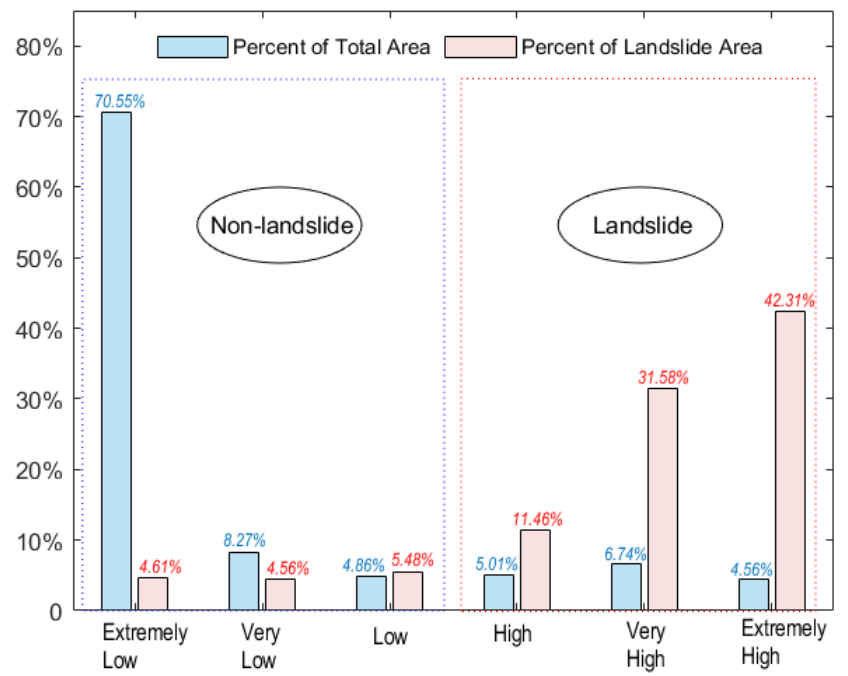
higher probability to landslide. Remote Sens. 2020 , 12 , x FOR PEER REVIEW